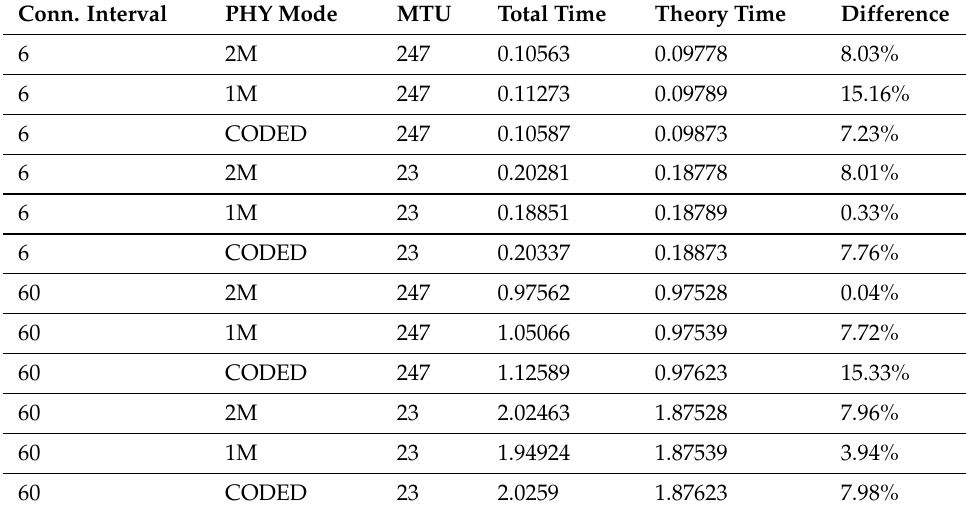
Table 2. Device 1 comparison practice to